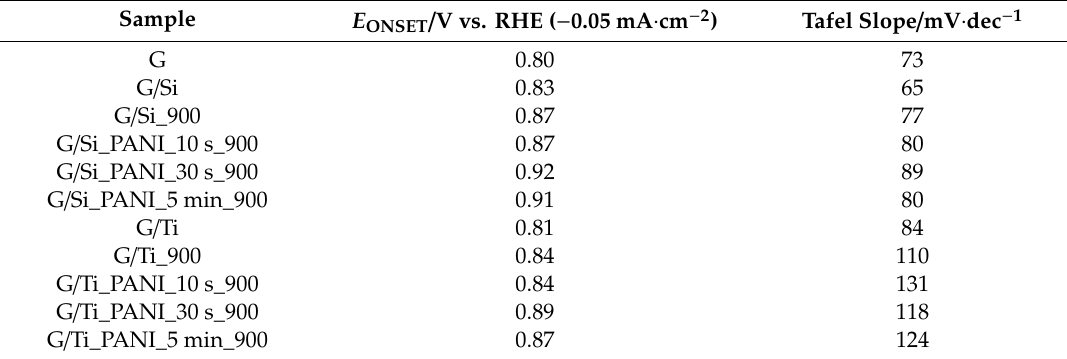
Table 3. Electrochemical parameters calculated from LSV curves of the di ff erent electrocatalysts in O 2 -saturated 0.1 M KOH solution at 50 mV · s − 1